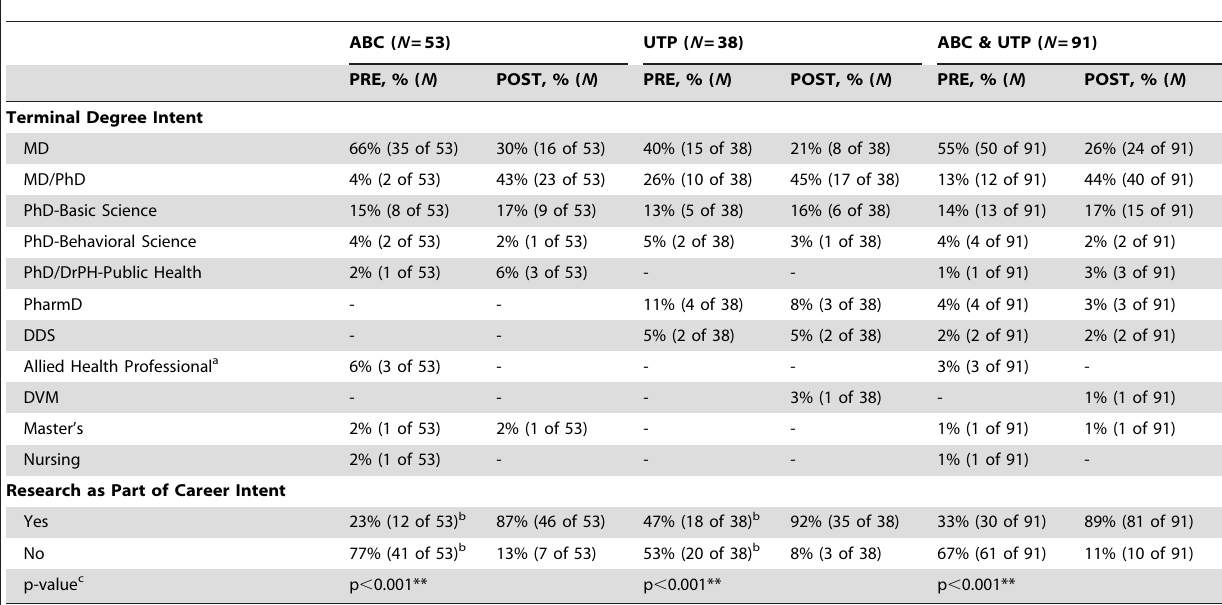
Table 2. Participants’ Terminal Degree and Research Career Intent Before and After the Summer Research Experience, ABC & UTP Participants